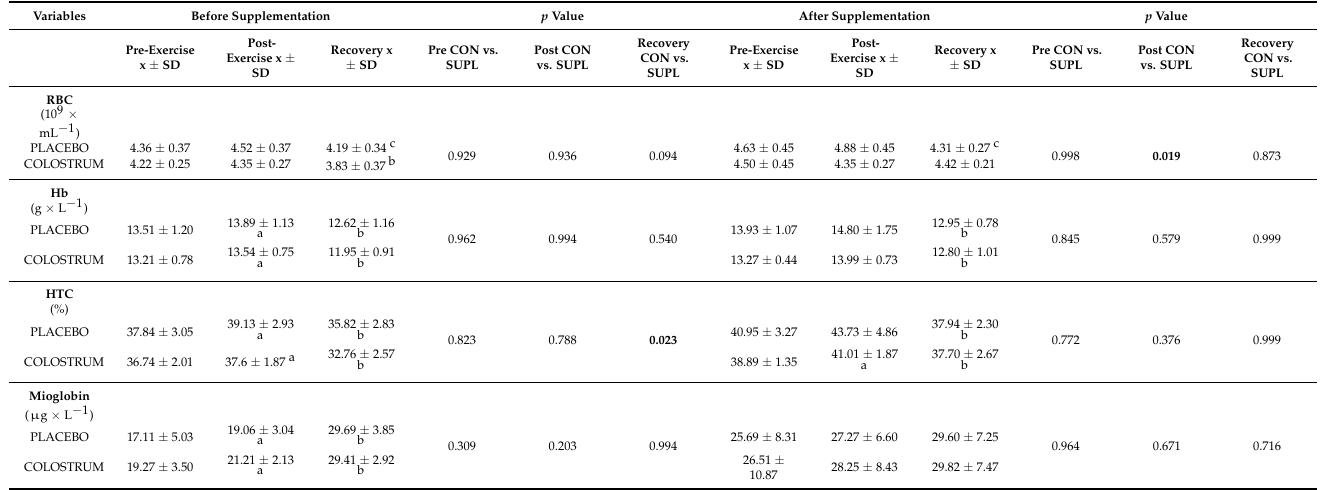
Table 4. Concentrations of RBC, Hb, HTC, and Myoglobin of athletes supplemented with colostrum bovine and with